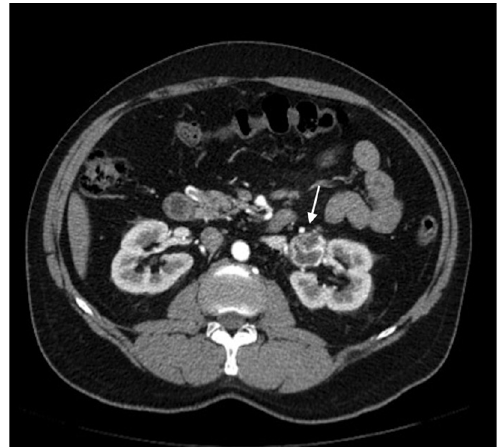
Figure 1 – Corticomedullary phase from the urotomography demonstrates the lesion (arrow) with wall and septa enhancement.